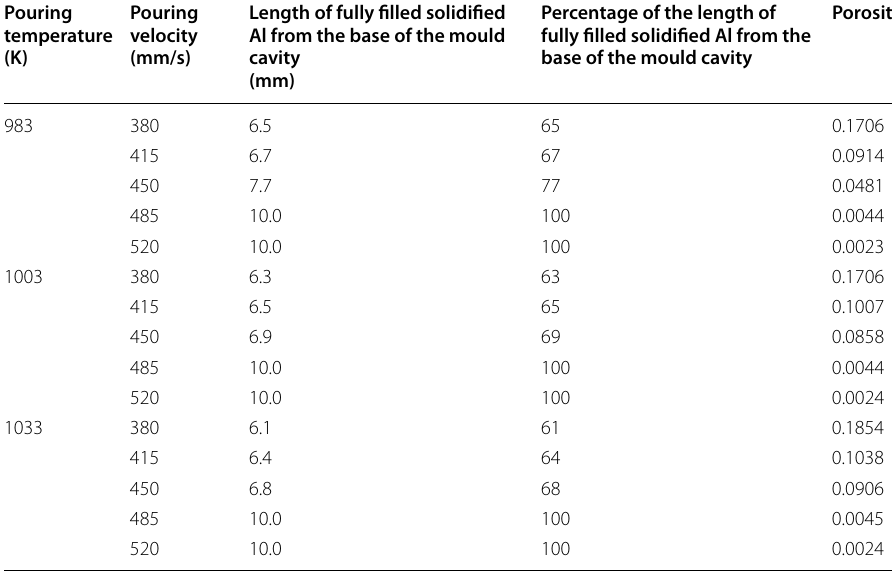
Percentage of the length of fully filled solidified Al from the base of the mould cavity